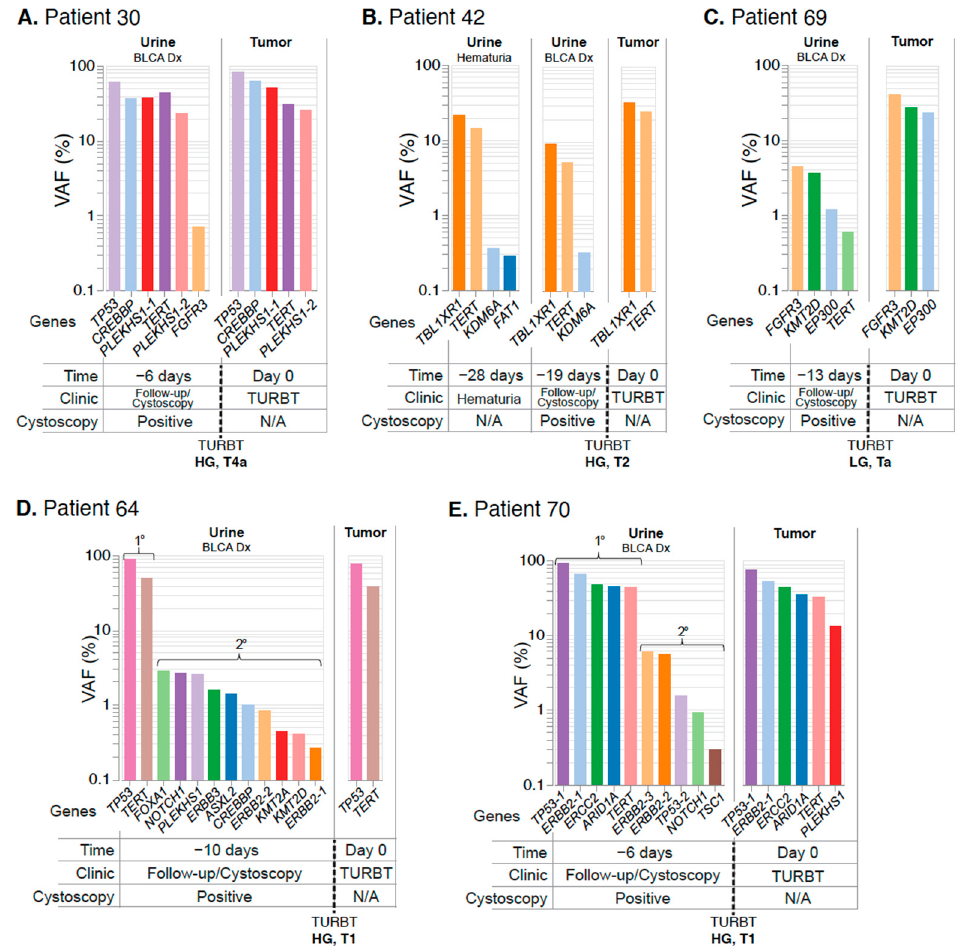
Figure 4. UroAmplitude urine analysis at the time of diagnosis establishes a comprehensive genomic profile of the tumor. The mutation profile of matched urine and tumor are grouped chronologically to demonstrate the somatic mutation concordance between urine samples at diagnosis and resected tumor. Tumor mutations are color-coded to facilitate identification across collections. When multiple mutations are identified in the same gene (ex. PLEKHS1 in Patient 30 and ERBB2 in Patient 70), each mutation is distinguished by color and given a numeric suffix. ( A – C ) demonstrate high tumor-in-urine concordance with few urine-exclusive events. ( D , E ) demonstrate high tumor-in-urine concordance with high numbers of urine-exclusive events (denoted as secondary). Abbreviations: primary (1 ◦ ), secondary (2 ◦ ), diagnosis (Dx), transurethral resection of bladder tumor